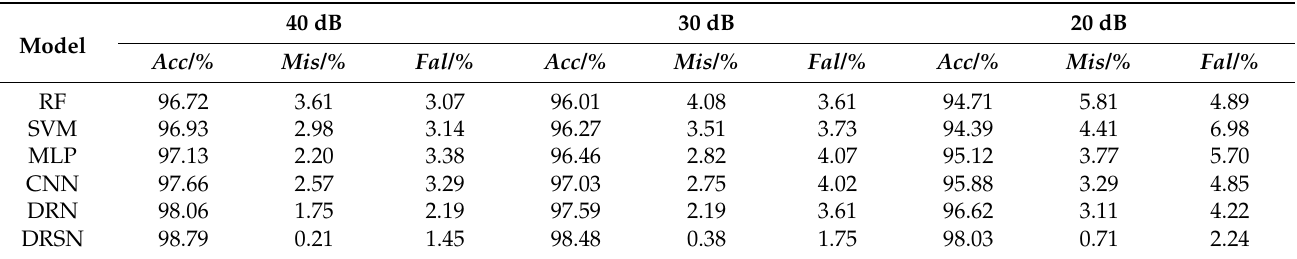
Table 2. Table 2. Performance of the different models on the modified New England 39-bus system with different SNRs.